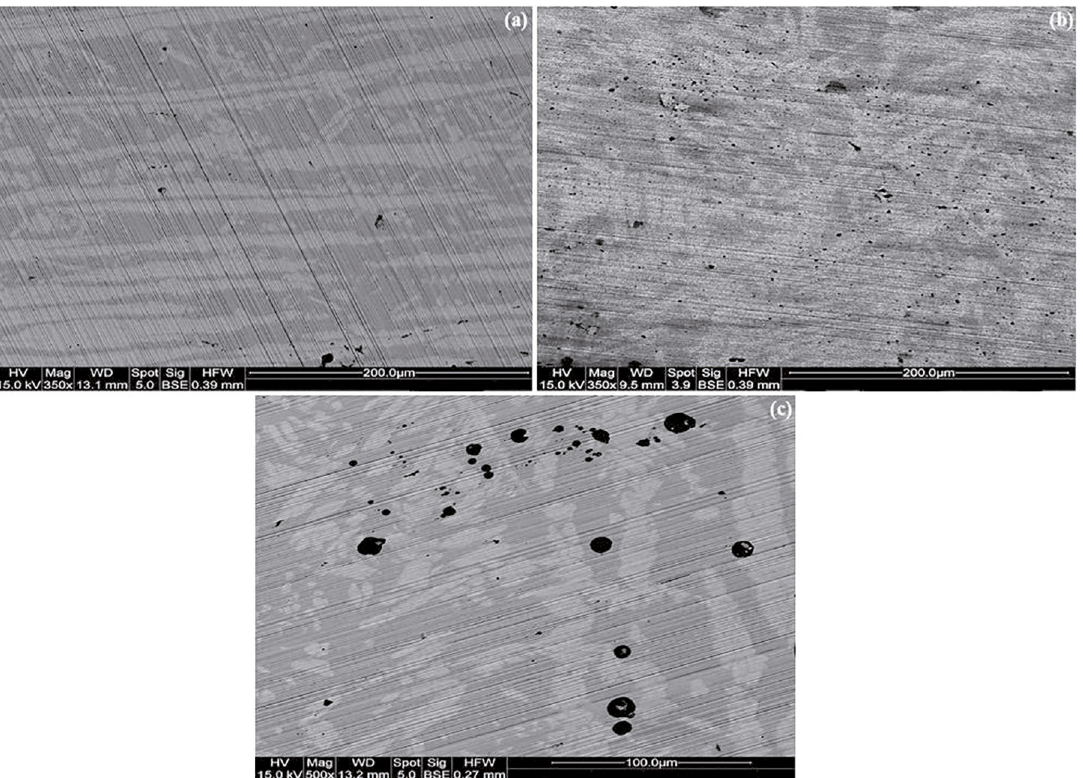
Figure 6: Pit morphologies after polarization measurements (SMAW 2307 top region): (a) BM (b) FZ and (c) HAZ